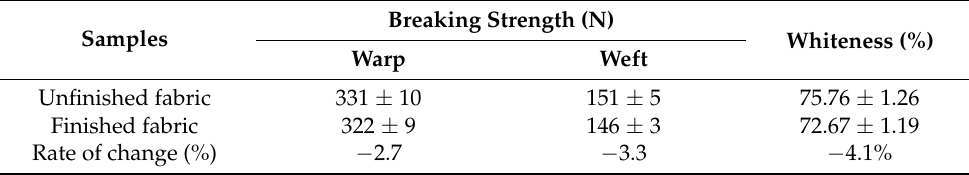
Table 1. The influence of water repellent finishing on the physical and mechanical properties of cotton